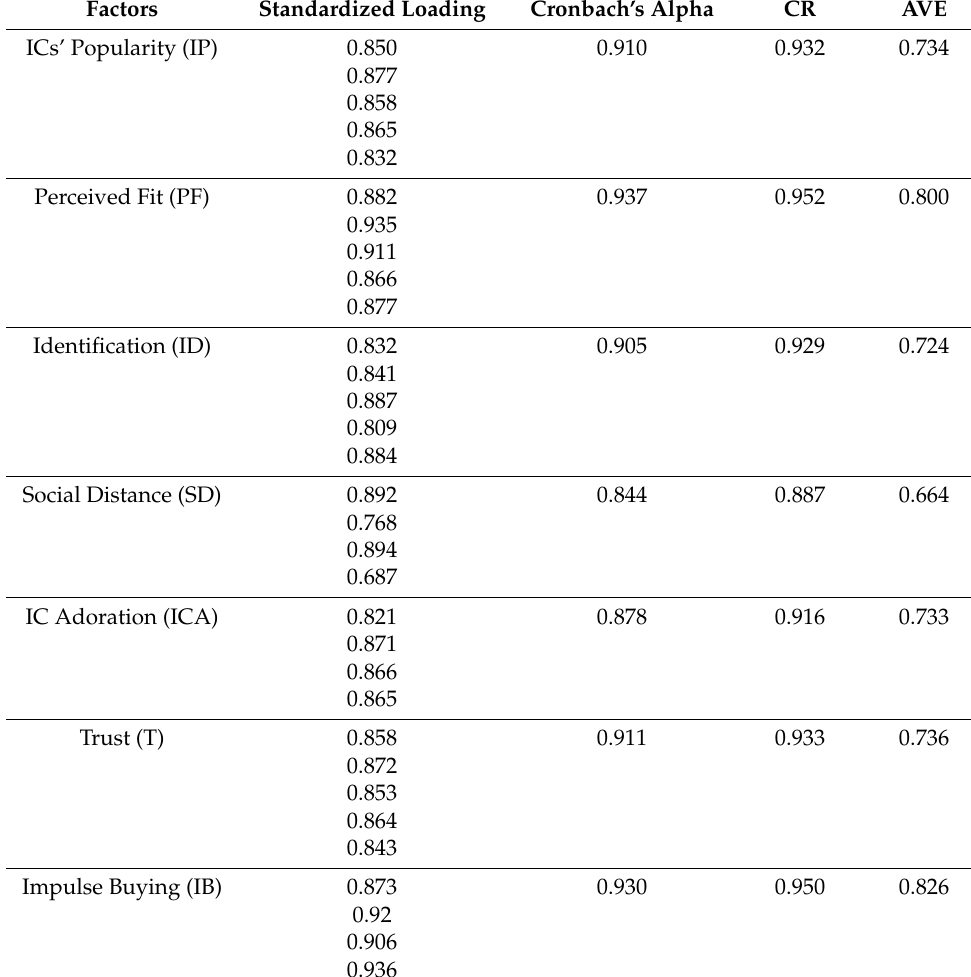
Table 3. Measurement model results (sample size =